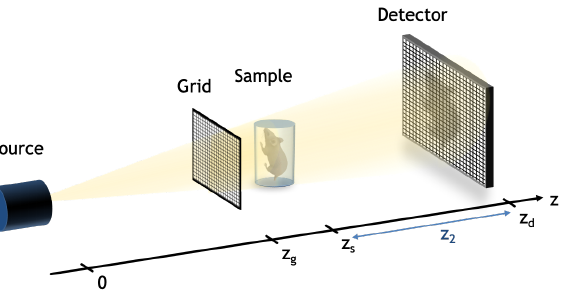
Figure 8. Mesh-based imaging set-up. The beam is modulated by a 2D grid before reaching the sample. The beam then propagates to the detector carrying information about the grid and the sample. Several images can be acquired with different positions of the